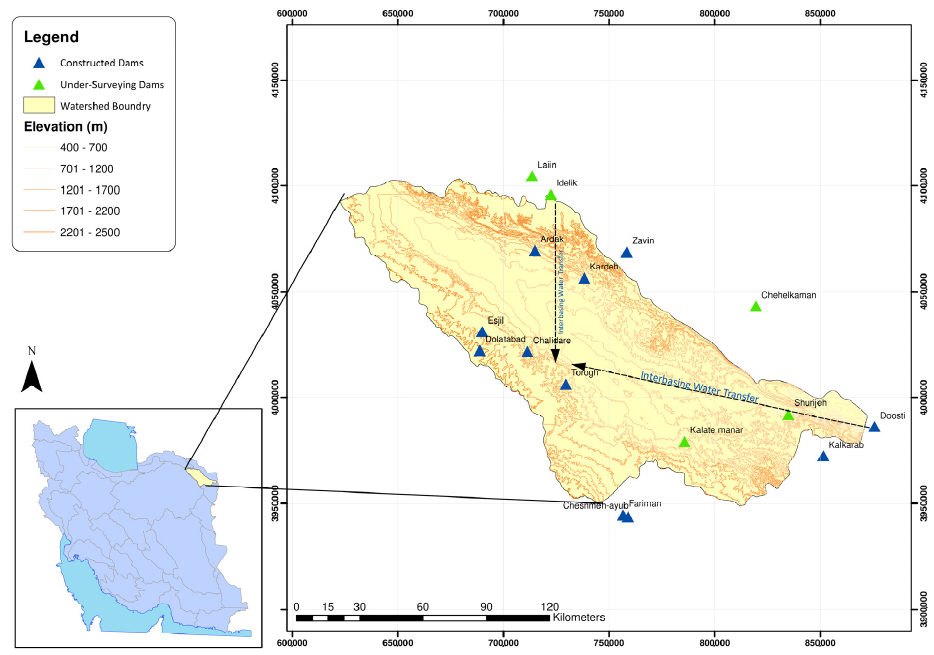
Figure 4. Location of Kashafroud in Iran and the existing and the under-studying water strategies.